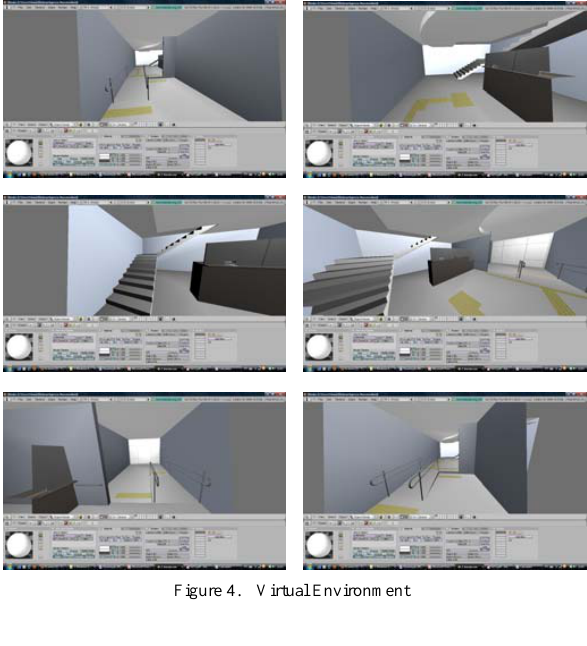
Figure 4. Virtual